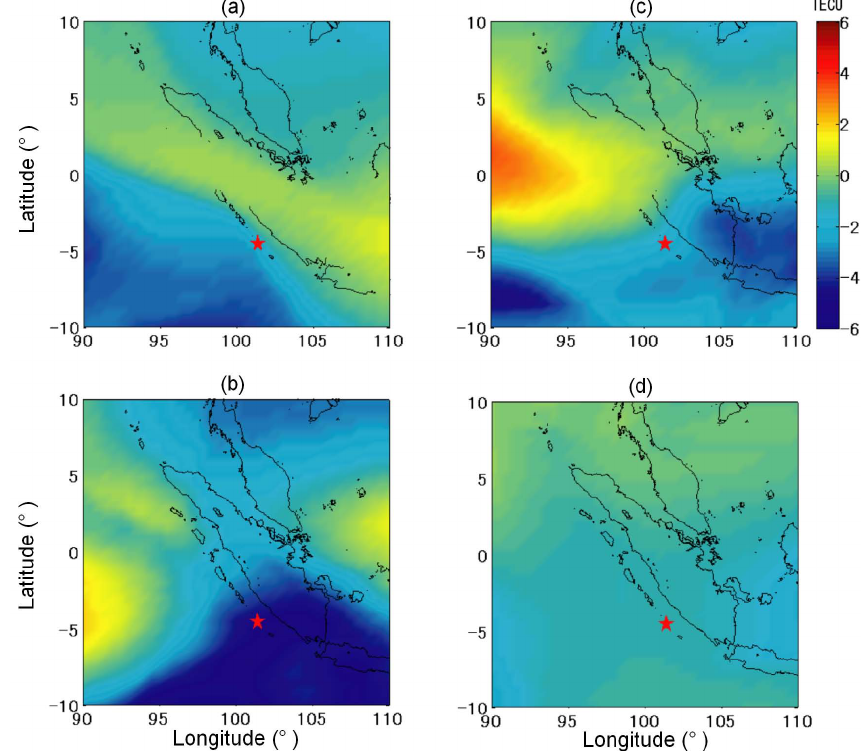
Fig. 9. Differences in the integrated electron content (IEC) between the observed and the reference data at 150km intervals from altitudes of 100 to 700km. (a) IEC at altitudes of 100 to 250km, (b) IEC at altitudes of 250 to 400 km, (c) IEC at altitudes of 400 to 550km altitudes, and (d) IEC at altitudes of 550 to 700km.